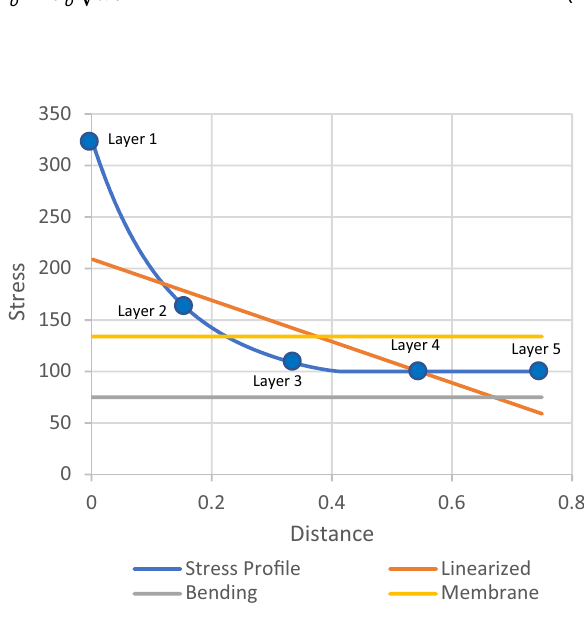
Fig. 2 Nonlinear stress profile and